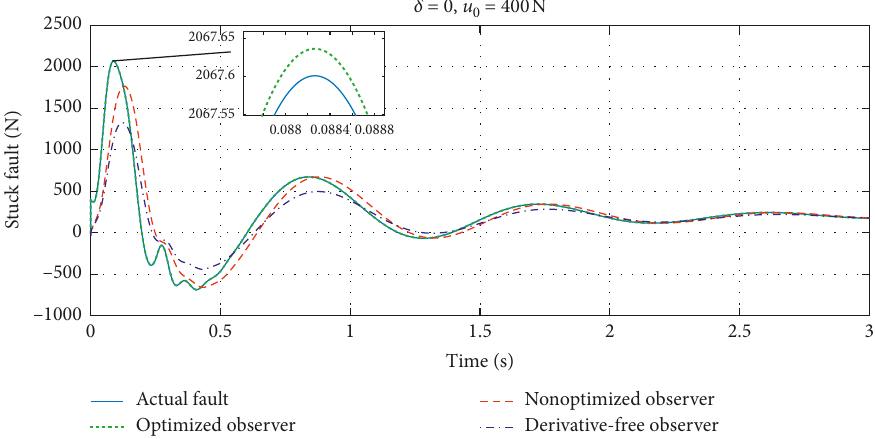
Figure 7: Tracking effects of the stuck fault ( bump road ). Table 7: Criteria for fault-type